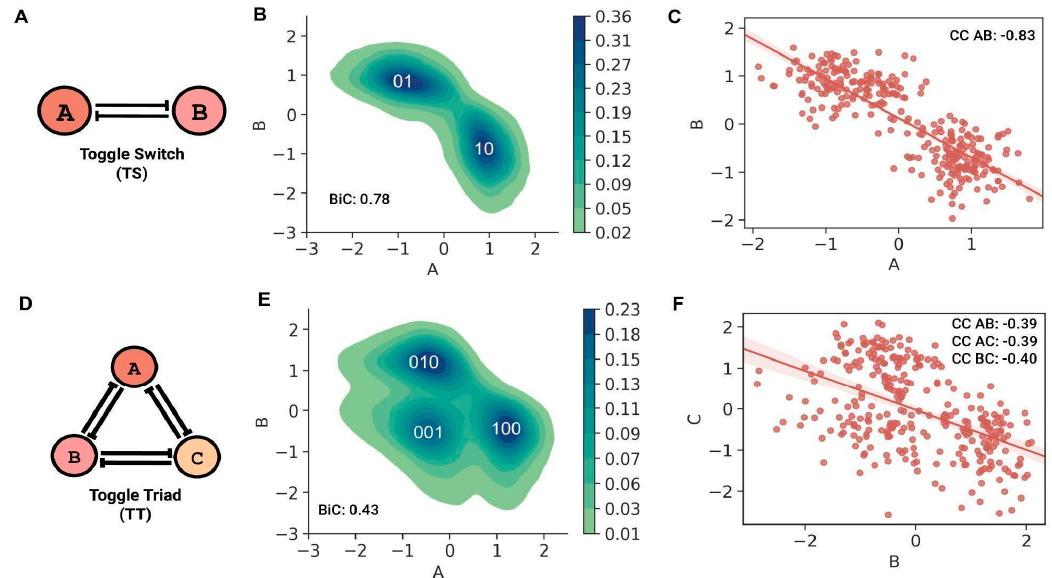
Figure 1. Stand-alone dynamics of two-node and three-node mutually repressing motifs. ( A ) A toggle switch (TS) motif comprises two nodes A and B that mutually inhibit each other. ( B ) Probability density plot of steady state values of nodes in a TS. The two dense clusters correspond to “single-positive” 01 and 10 steady states (F1) of a TS. ( C ) Regression plot between the steady states values of two nodes, A and B of a TS. Correlation coefficient (CC AB) between them is − 0.83. ( D ) A toggle triad (TT) motif comprises three mutually repressing nodes A, B, and C. ( E ) Probability density plot of steady-state values of two TT nodes A and B; the three clusters represent three “single-positive” steady states (F1), 001, 010, and 100. ( F ) Regression plot between steady state values of nodes B and C of a TT. Correlation coe ffi cient (CC BC) = − 0.39. Other pairwise correlation coe ffi cient values are also mentioned: CC (AC) = − 0.39, CC (AB) = − 0.40.